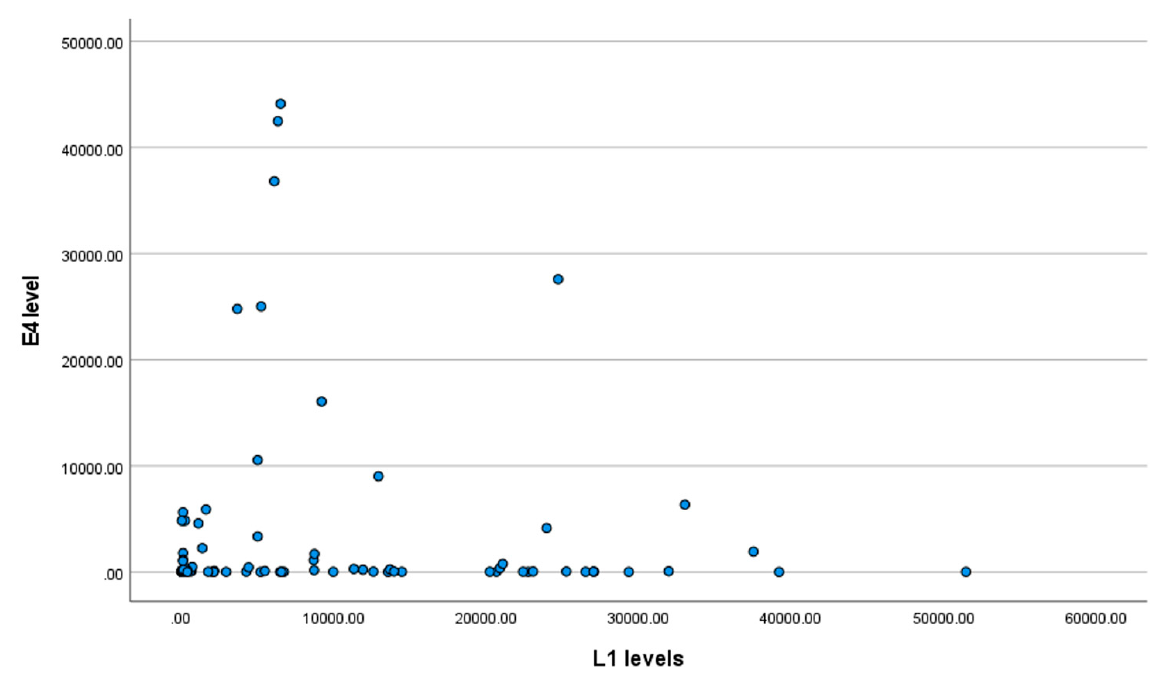
Figure 4. Scatter plot for the E4 protein level and L1 level.